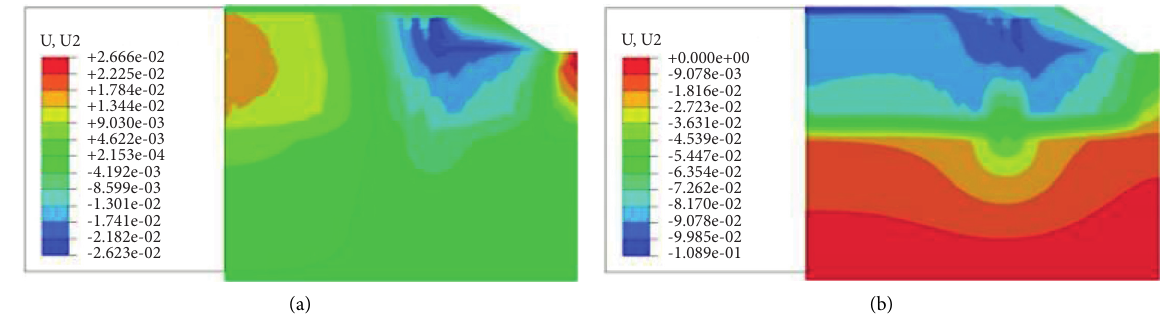
Figure 10: Settlement cloud diagram of widened subgrade for a pile length under the existing subgrade and new embankment equal to 4.7m. (a) Settlement cloud diagram of subgrade completion. (b) Settlement cloud diagram 15 years after subgrade construction.